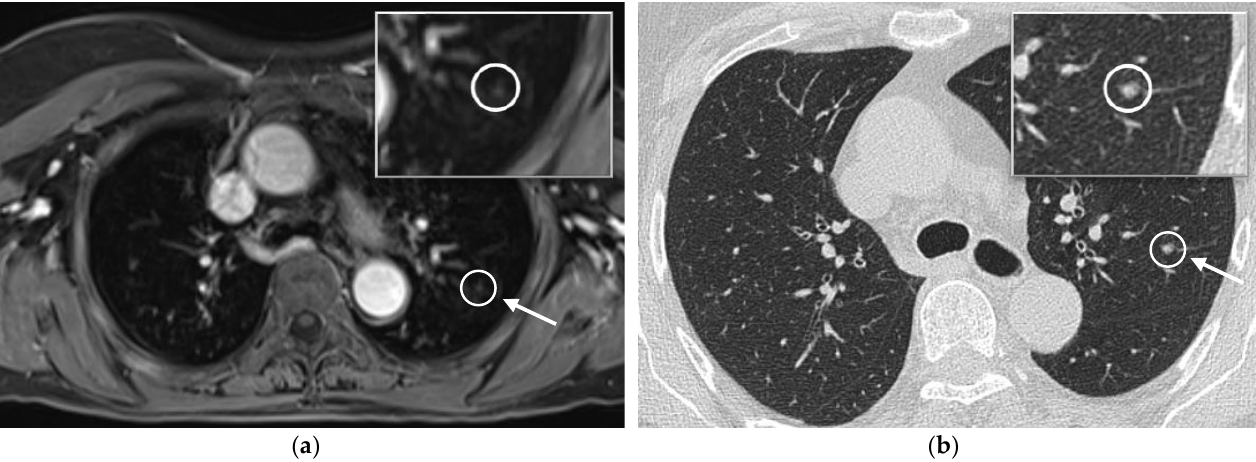
Figure 2. Example of the assessment of the lung in the 20-min-WB-MRI-protocol: example of axial pre- ( a ) and post-contrast T1w VIBE Dixon of the thorax ( b ) in a 25-year old patient with malignant melanoma and currently no evidence of disease. Please note that the images have been cropped, as the skin tissue was part of the acquisition.